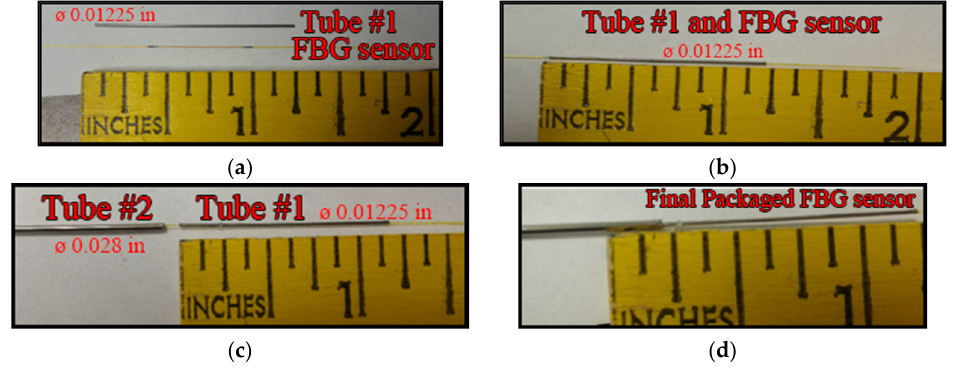
Figure 5. FBG sensor packaging. ( a ) FBG sensor and packaging tube; ( b ) FBG sensor in packaging tube; ( c ) Communication fiber protection tube; ( d ) Connection between two